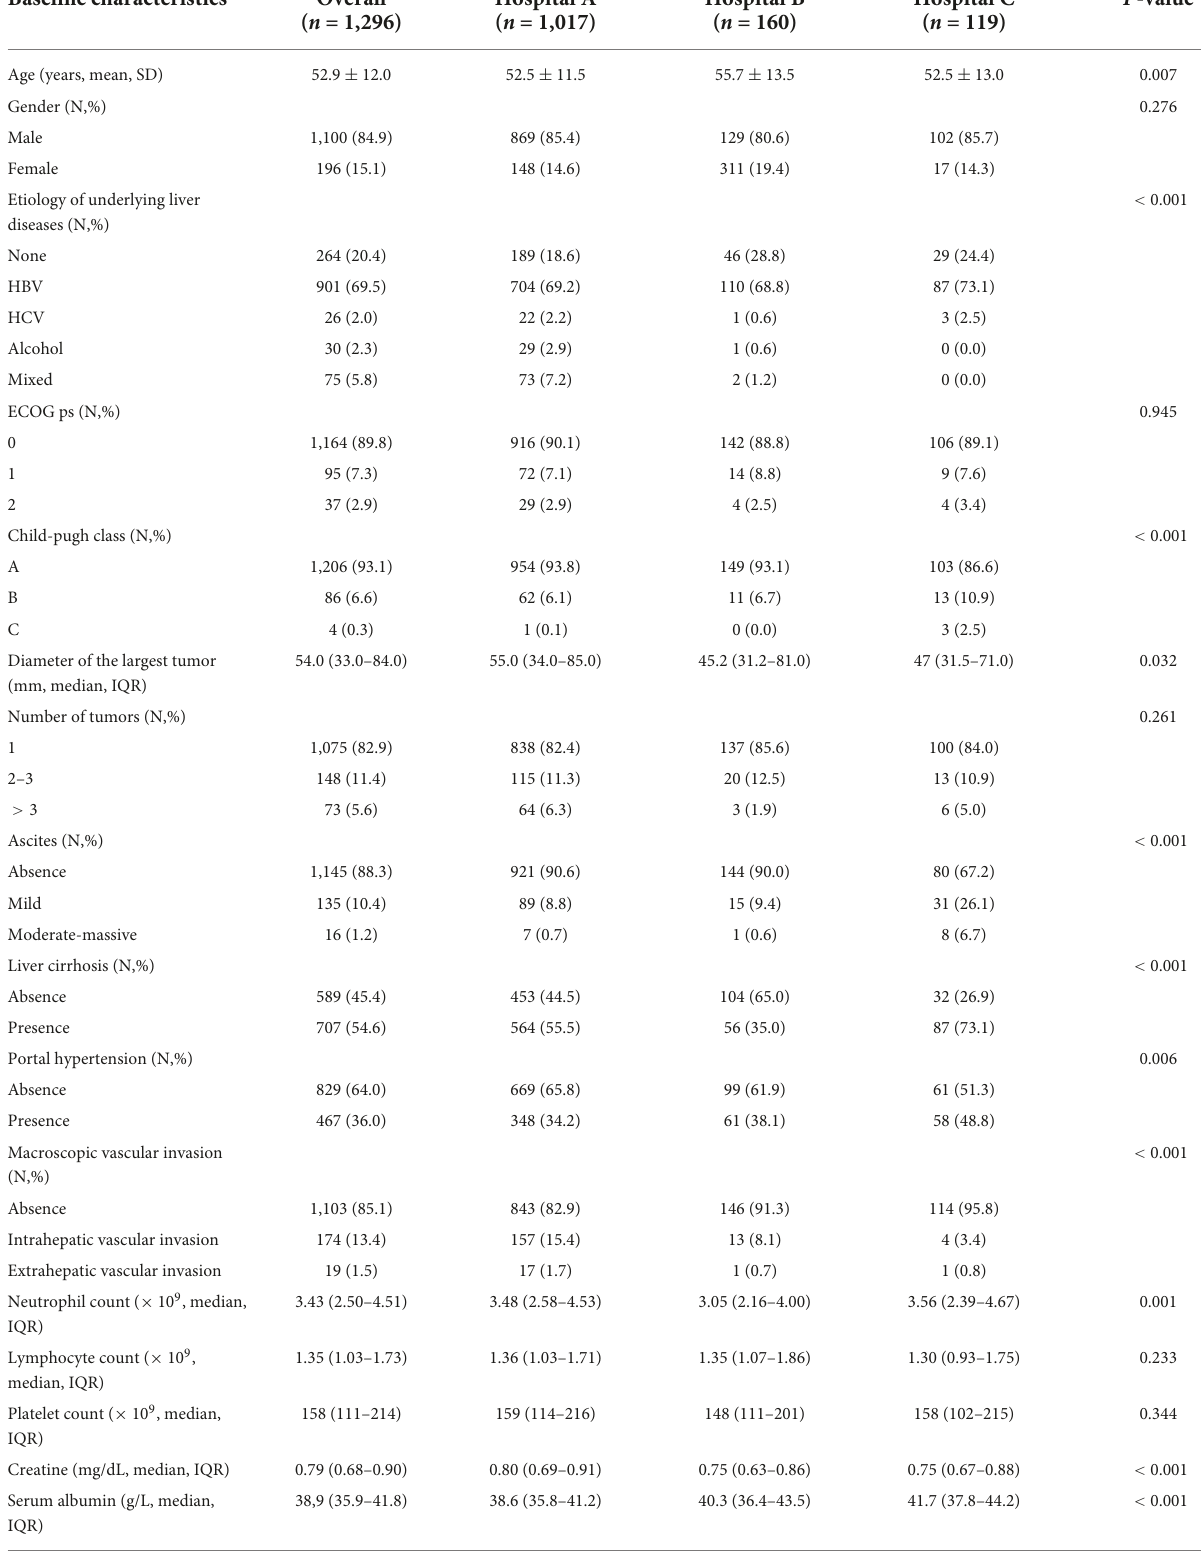
TABLE 1 Baseline characteristics of the entire study